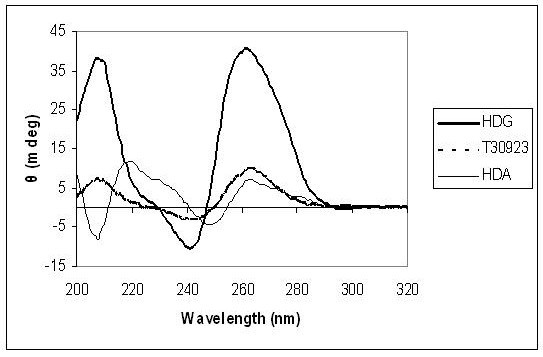
CD spectroscopy of HDA and HDG. CD spectra of 15 μM HDG (heavy solid line), 15 μM T30923 (light solid line) and 15 μM HDA (dotted line) in 10 mM KCl at 24°C.